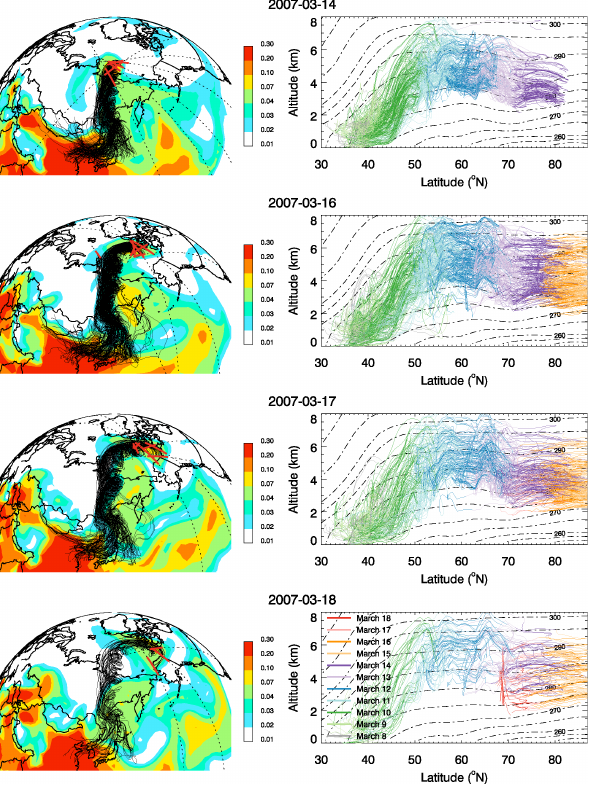
Figure 6. Same as Figure 1 but for March 14-18, 2007. The potential temperature contours (right panels) are zonally and Fig. 6. Same as Fig. 1 but for 14–18 March 2007. The potential temporally averaged in the longitude interval [110ºE, 160ºW] from March 9, 0Z until the time when the last plume was observed, for each day. temperature contours (right panels) are zonally and temporally av- eraged in the longitude interval (110 ◦ E, 160 ◦ W) from 9 March, 0Z until the time when the last plume was observed, for each